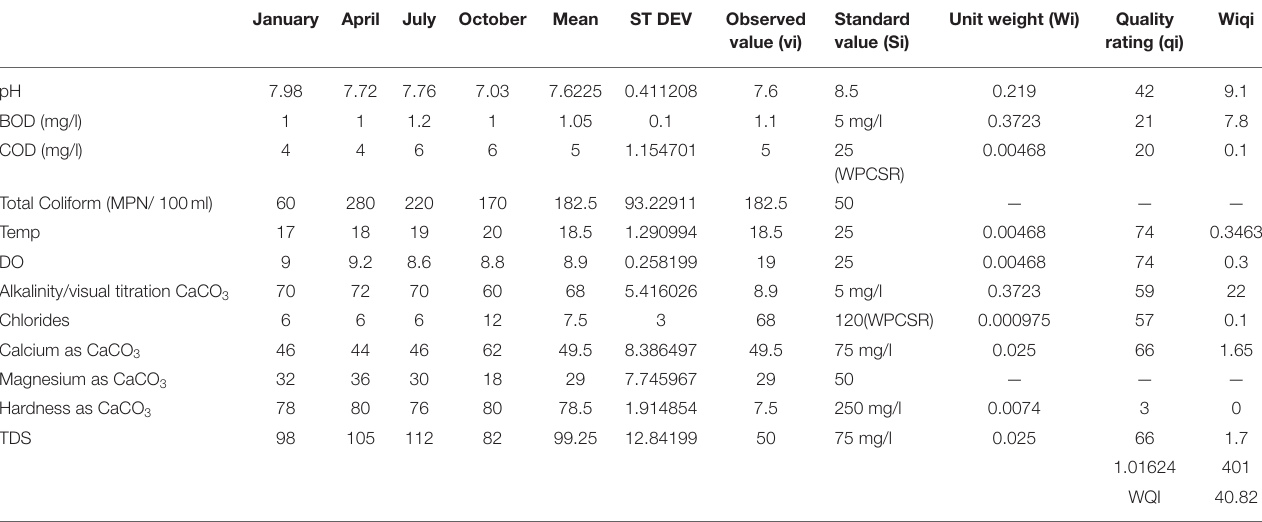
TABLE 4 | Physicochemical parameters and water quality analysis at Dehradun for